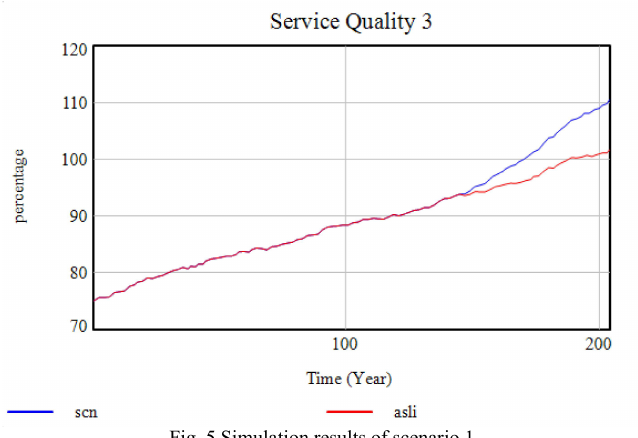
Fig. 5 Simulation results of scenario 1